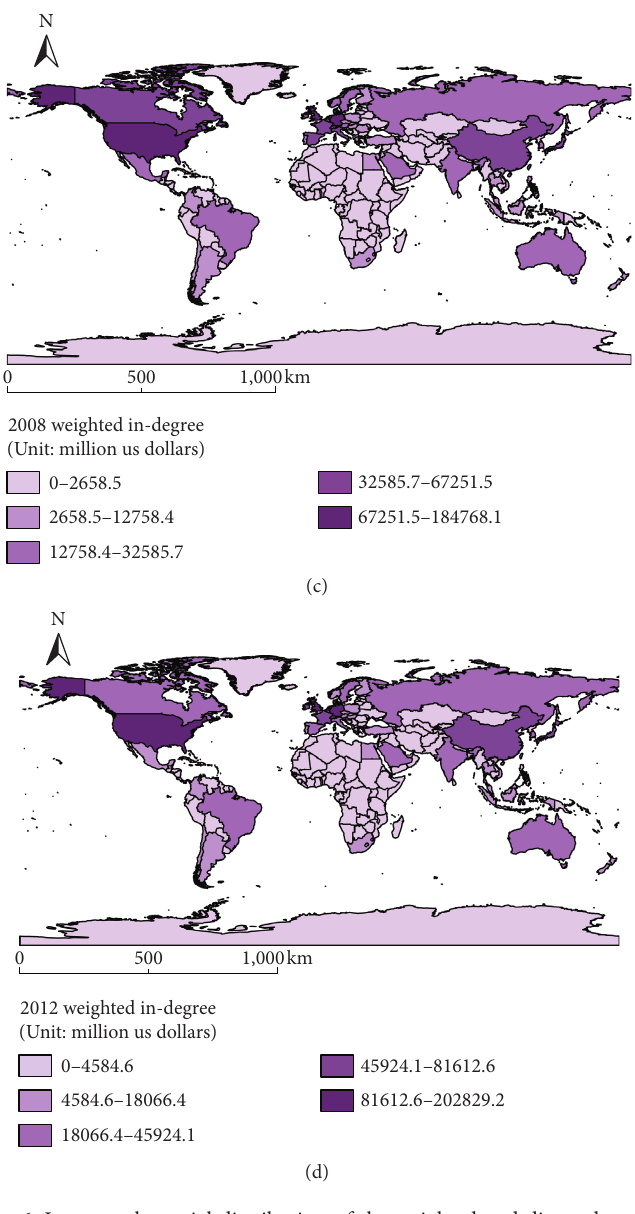
Figure 6: In-strength spatial distribution of the weighted and directed